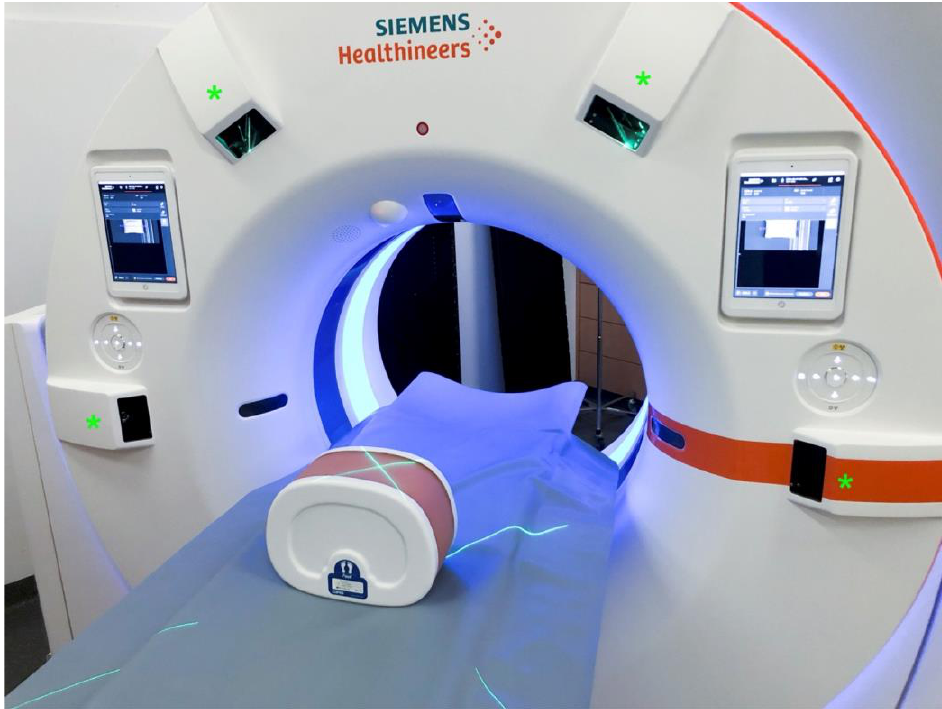
Figure 1. Gantry with four laser projectors mounted onto the housing (green asterisk). Visualization of a planned needle path by two intersecting fan beam lasers projected onto the phantom.